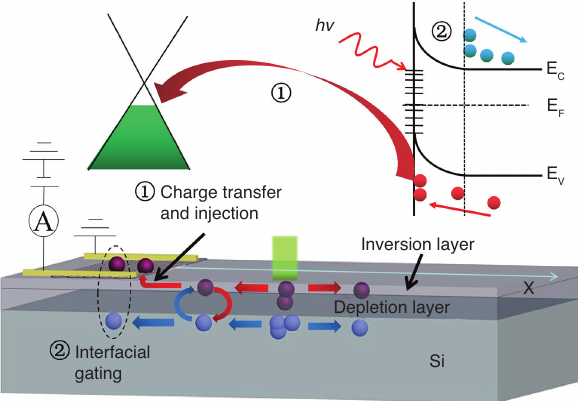
Figure 4: Energy band and carrier dynamics of the PSD. The photo-induced holes drift to the surface of Si under the built-in electric field, which is followed by diffusion laterally in the inversion layer and injection into the graphene. While the electrons in bulk Si move to the region under graphene, which will cause interfacial gating